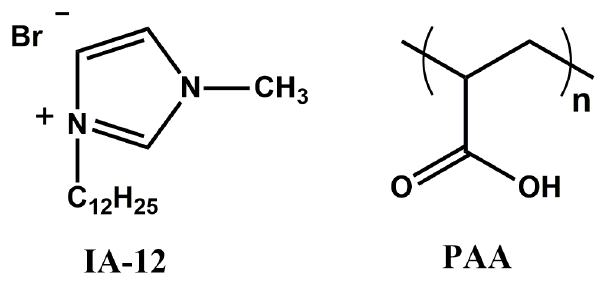
Figure 1. Chemical formulas of IA-12 and PAA studied in this report.